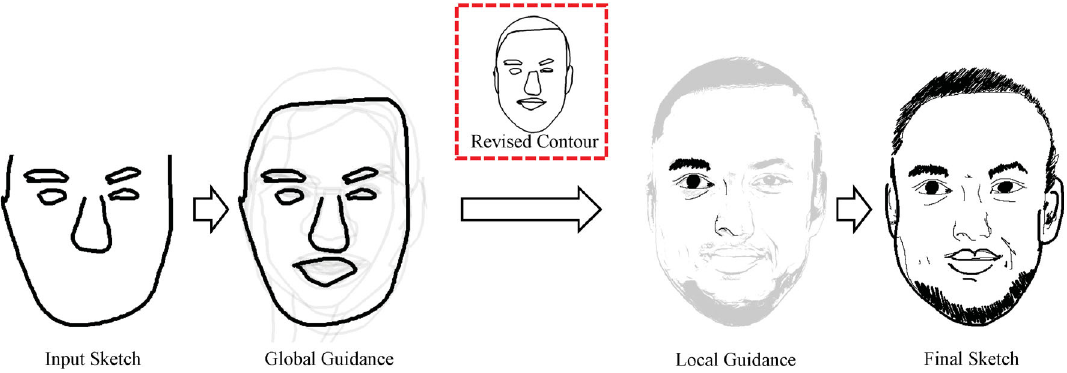
Fig. 1 Proposed portrait drawing interface, providing both global and local guidance from the input user sketch. The revised contour sketch in the back end is from the merged mask generated by our conversion algorithm from the input sketch, and is the reference for local guidance